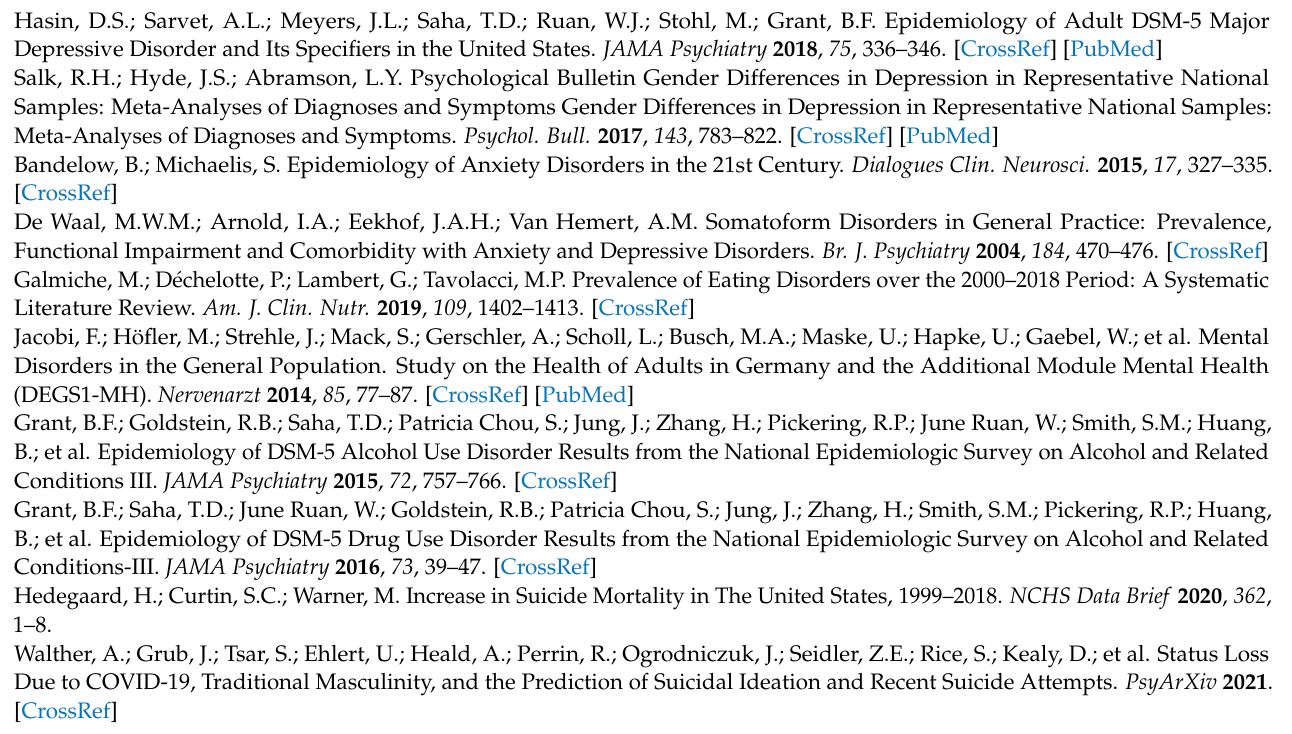
S-Figure 1: Odds Ratios for current Psychotherapy Use for Male Students; S-Figure 2: Odds Ratios for current Psychotherapy Use for Feale Students; S-Figure 3: Odds Ratios for Intention to Start Psychotherapy for Male Students; S-Figure 4: Odds Ratios for Intention to Start Psychotherapy for Female Students; S-Figure 5: Significant Moderations; S-Figure 6: Sample flow diagram leading to final sample; Results S1: Exploratory moderation